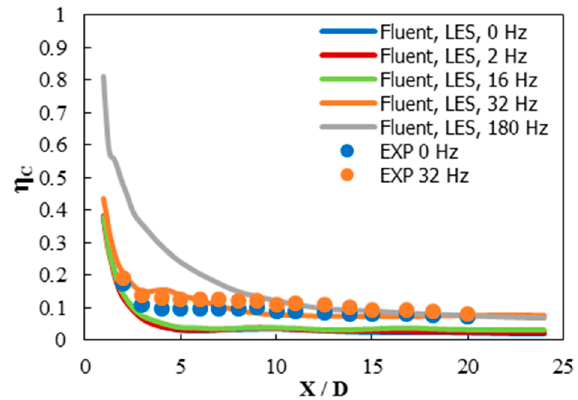
Figure 37. The centerline effectiveness obtained using the LES Smagorinsky–Lilly model for M = 1.0 for the 0, 2, 16, 32, and 180 Hz oscillations.